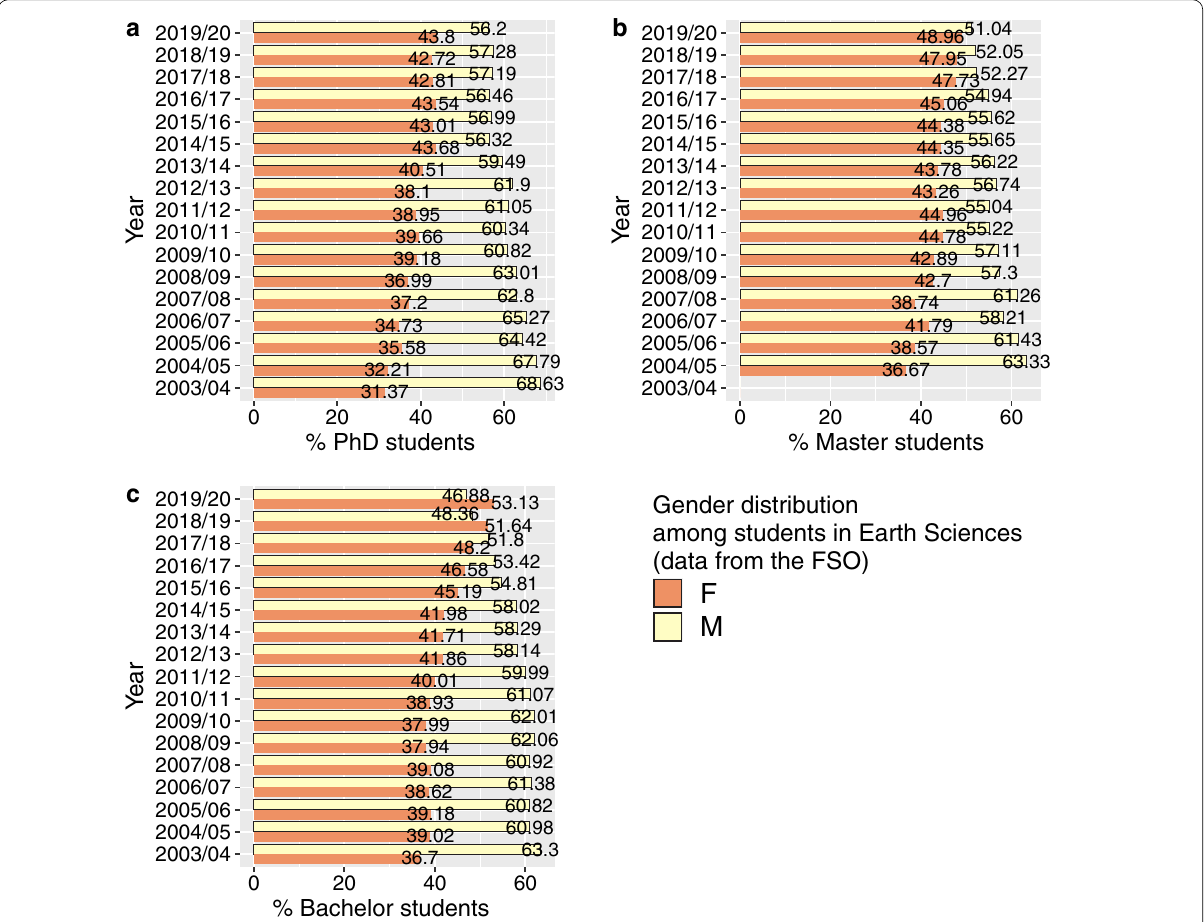
Fig. 4 Percentage of PhD ( a ), Master ( b ) and Bachelor (c) students in Earth Sciences in Switzerland classified by gender (data from the Swiss Federal Statistical Office (FSO), http://www.pxweb .bfs.admin .ch/sq/b2e47 8b2‑be7a‑425d‑b4a8‑953fc 41162